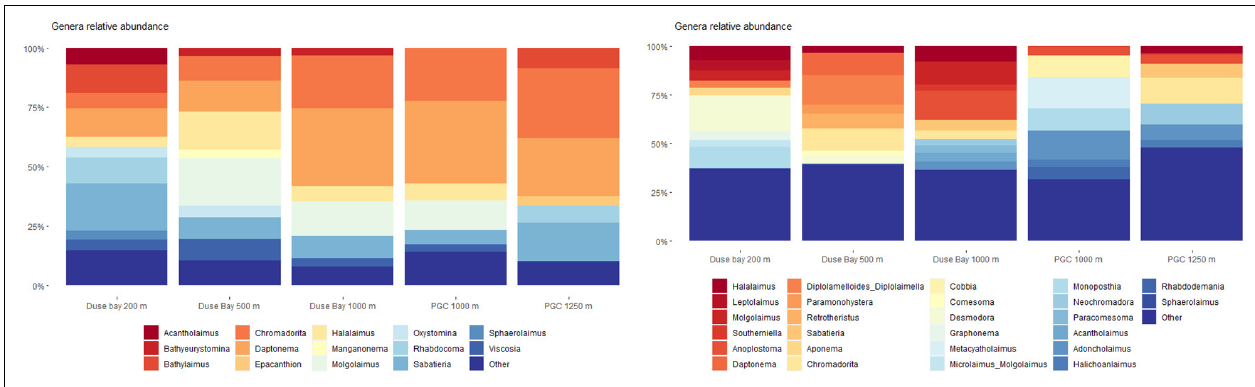
FIGURE 6 | Nematodes community composition for the most abundant genera ( > 3%). Comparison between ASVs (A) and morphologically identified dataset (B) ; less abundant genera ( < 3%) were pooled in the “Other” item.From left to right, image sequence of ice melting in the Eastern Antarctic Peninsula during the 4 months preceding the JR17003a research campaign. Satellite images source: